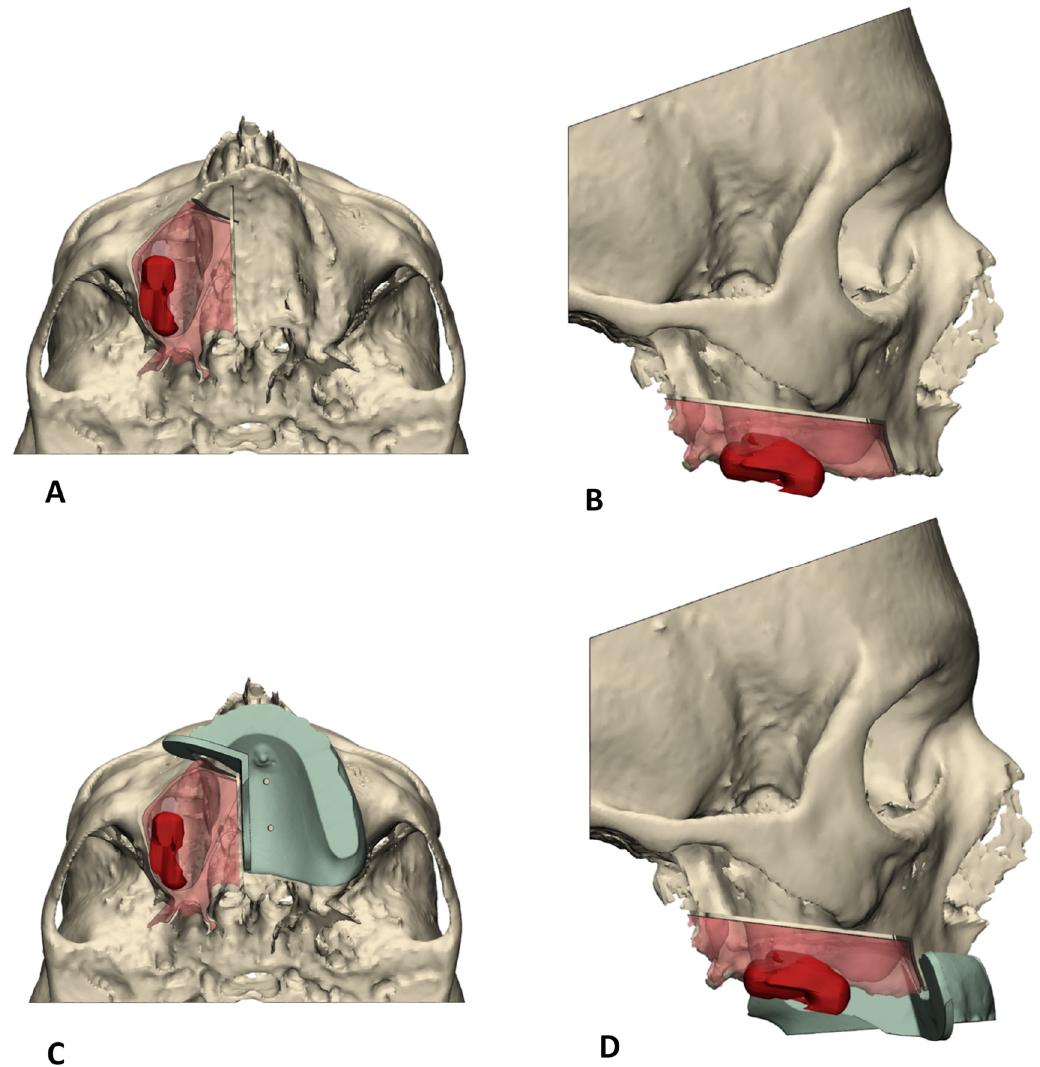
Figure 1. Overview of 3D VSP workflow for virtual resection planning. The working method starts with right-sided maxillectomy ( A ), caudal view ( B ), and the matching lateral view guided by the surgical cutting guides ( C , D ), with which the aim is to remove the red transparent part representing tumor removal with margin.